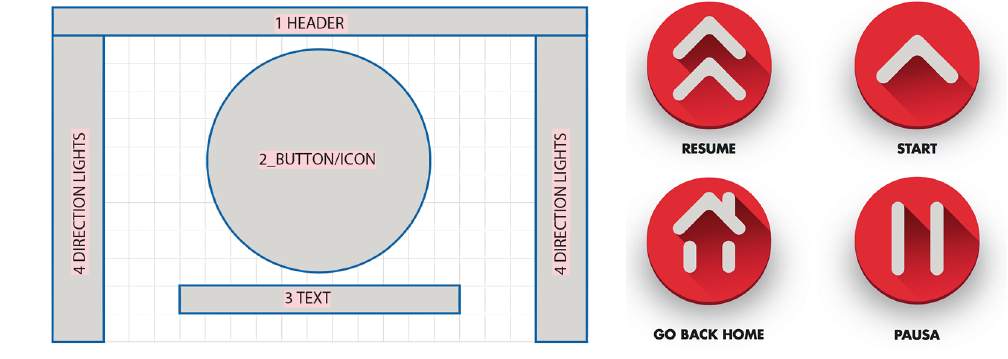
Figure 5. In the screen grid, the elements correspond to: 1—the header, which host the logo and the company layout, 2—the maximum area dedicated to the button, 3—brief text to explain the button function if needed, and 4—the direction of lightening that provides an easier way to understand the robot’s path. On the right side of the picture, we can see some icons created for the graphic layout.